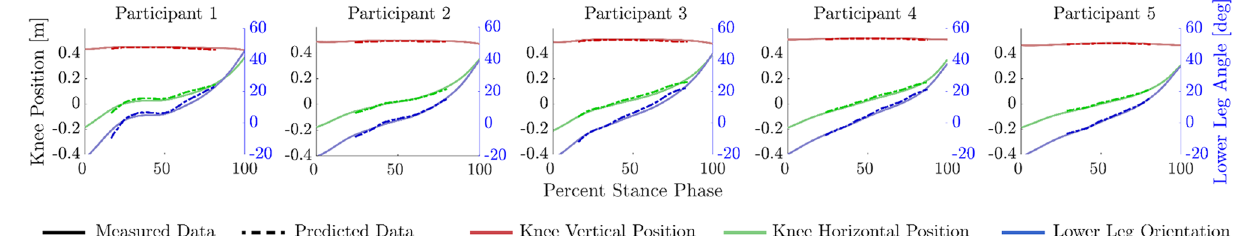
Figure 3. Measured and calculated lower leg trajectories during stance phase for a single representative step for each participant walking with the LLTE prosthesis. The trajectories are defined by the horizontal and vertical coordinates of the knee ( x knee , y knee ) and orientation of the lower leg segment ( θ shank